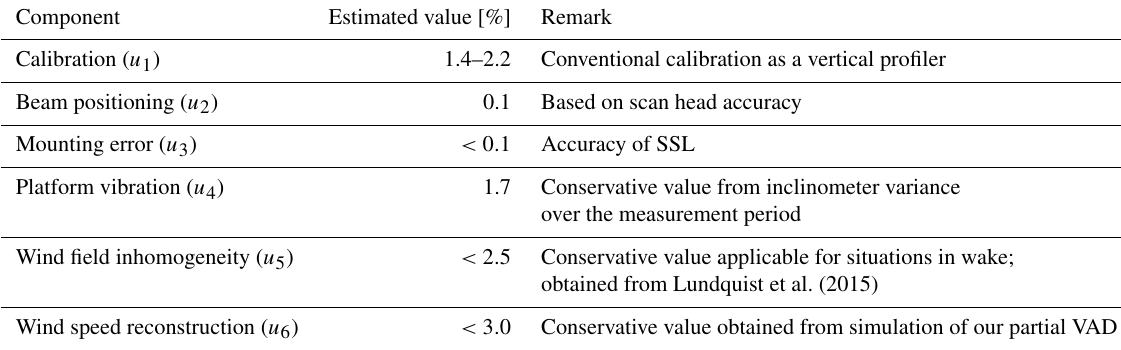
Table A1. Summary of uncertainty components that contribute to the global uncertainty of the wind measurement with the scanning lidar and analysis techniques used during this project.